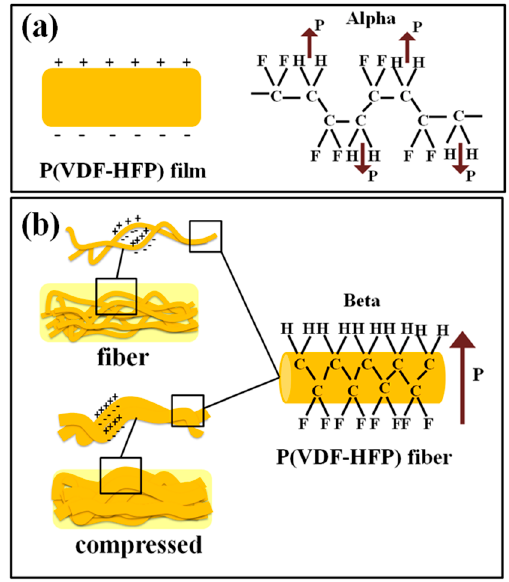
Figure 8. Schematic of the proposed β -phase transformation mechanism .